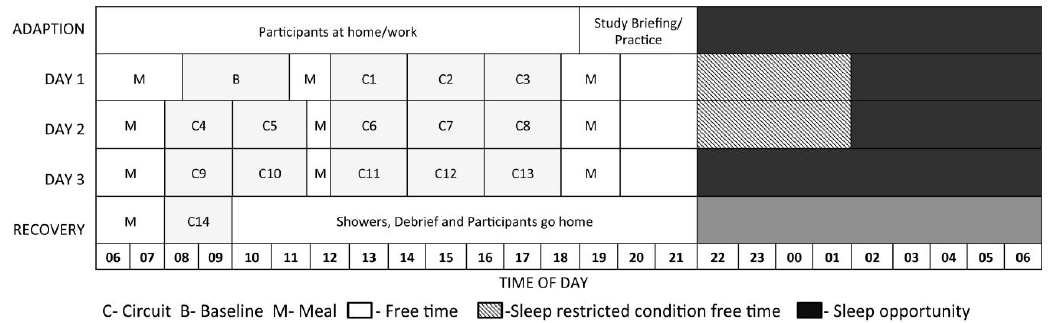
Figure 1. The study protocol outlining each testing circuit, scheduled meal times, free time, and sleep opportunity. Participants in the sleep restricted conditions were given an extended free time.